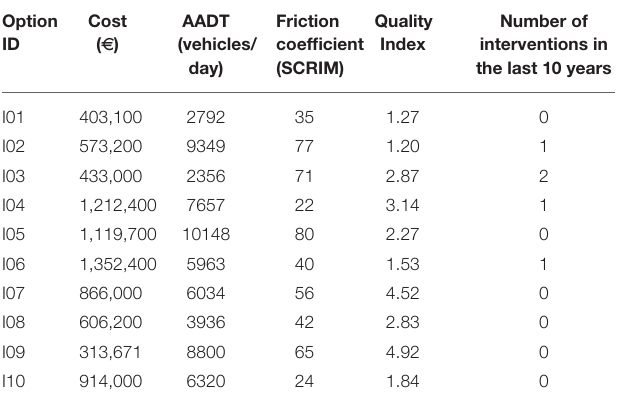
TABLE 6 | Possible intervention options.